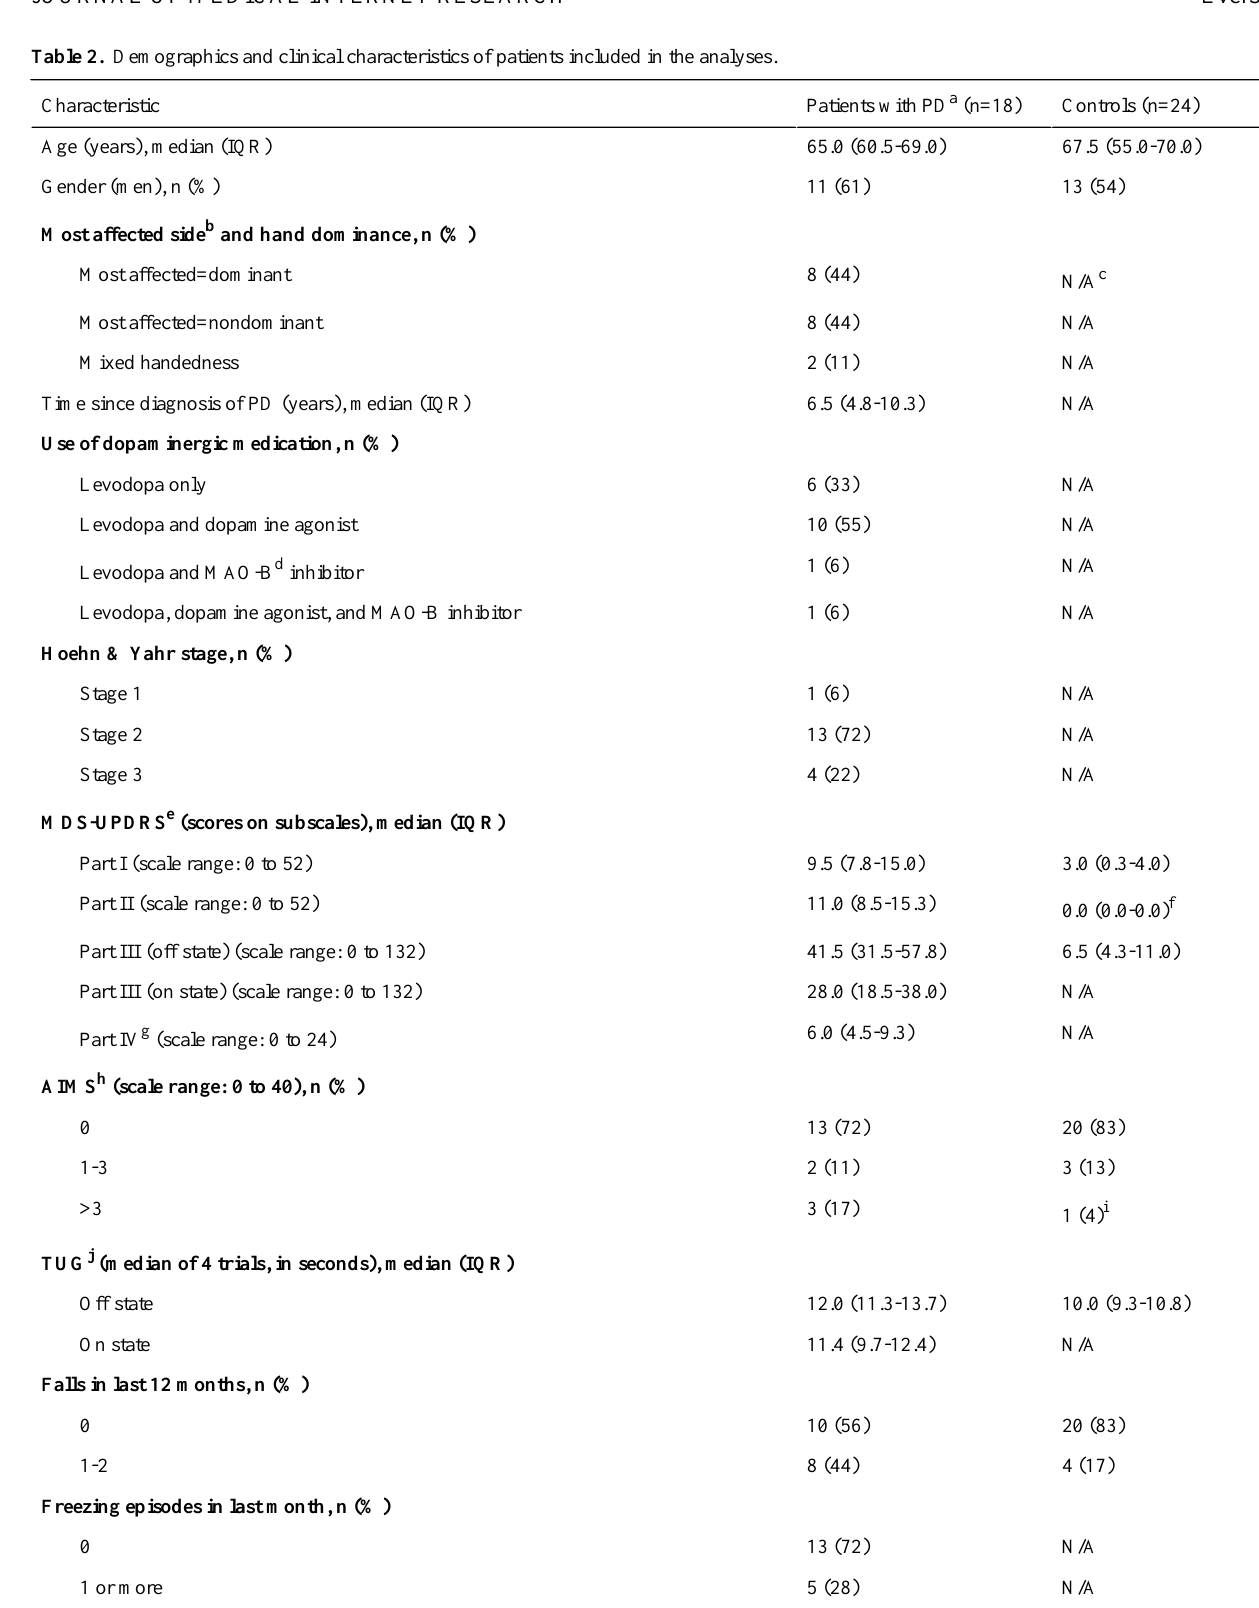
Table 2. Demographics and clinical characteristics of patients included in the